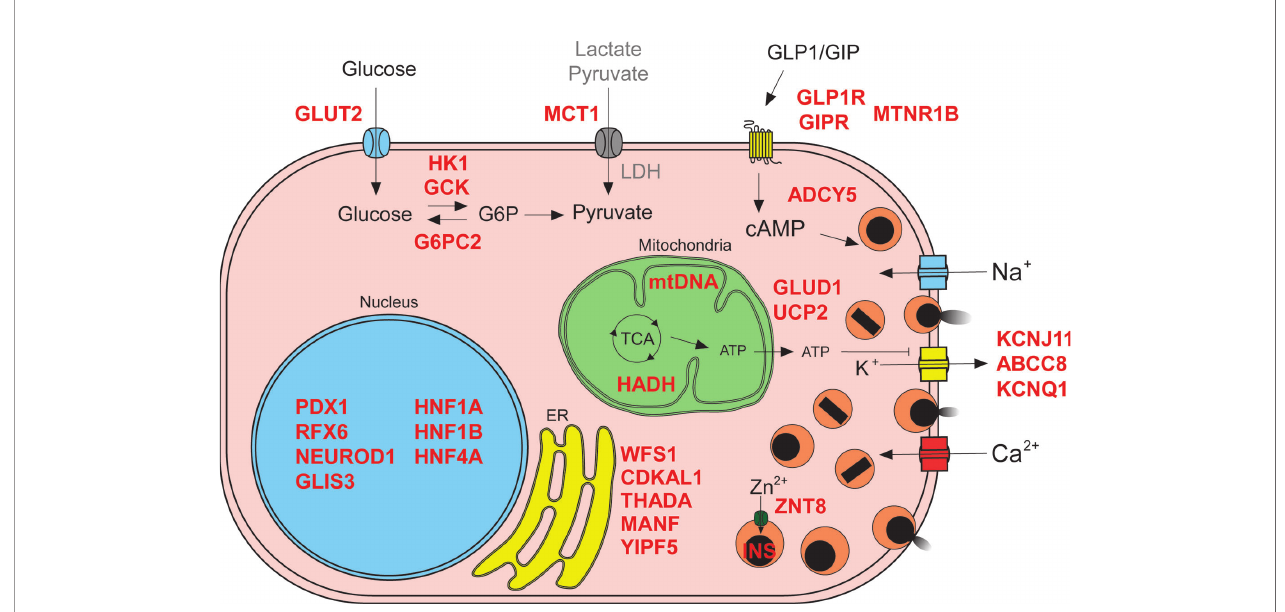
FIGURE 1 | Insulin secretion molecular mechanisms affected in diabetes. Genetic defects can impair different processes involved in regulated insulin secretion (known genes affected in red text): glucose import and metabolism (G6P, glucose 6-phosphate; LDH, lactate dehydrogenase; TCA, tricarboxylic acid cycle; abnormal beta cell metabolism of non-glucose carbon sources due to failure in silencing of disallowed genes depicted in gray text), membrane depolarization, membrane receptors, insulin synthesis and secretion, endoplasmic reticulum (ER) homeostasis, and transcriptional